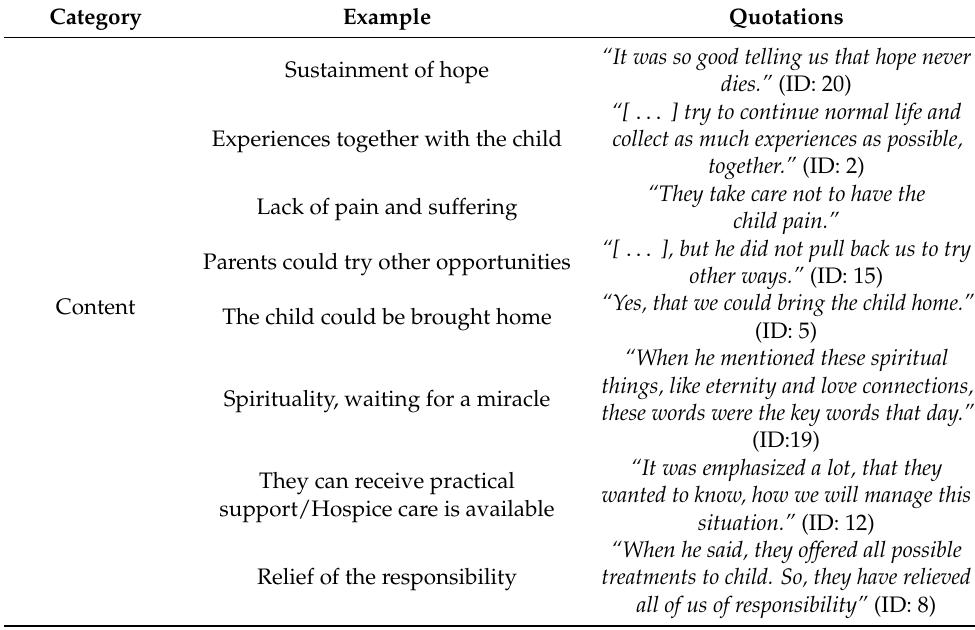
Table 3. Categories, examples, and quotations of Code 2.1.1 (positive verbal